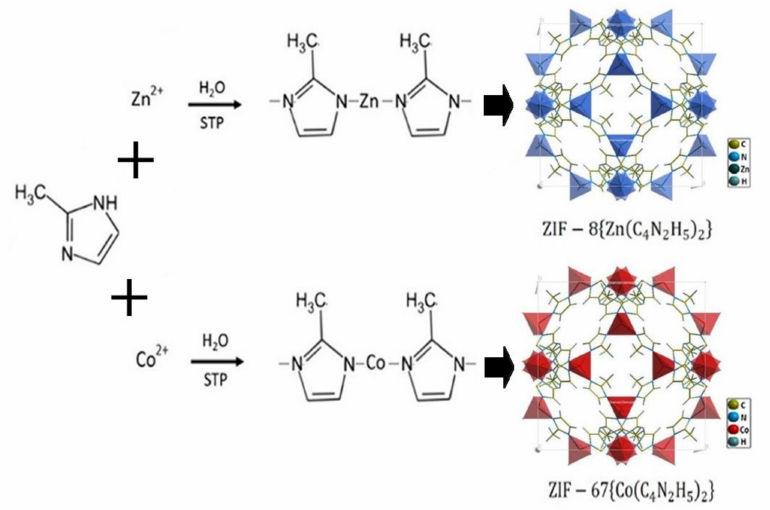
Figure 1. Representative synthesis and crystal structures of ZIF-8 and ZIF-67 used as the sensitive layers of gas